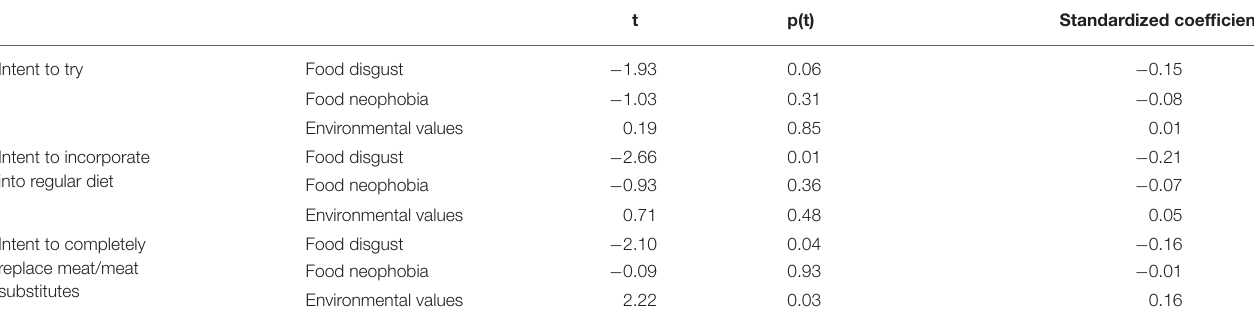
TABLE 2 | Predictors (linear regression) of initial intent to try culture meat, incorporate it into regular diet, and completely replace meat/meat substitutes with it. t p(t) Standardized